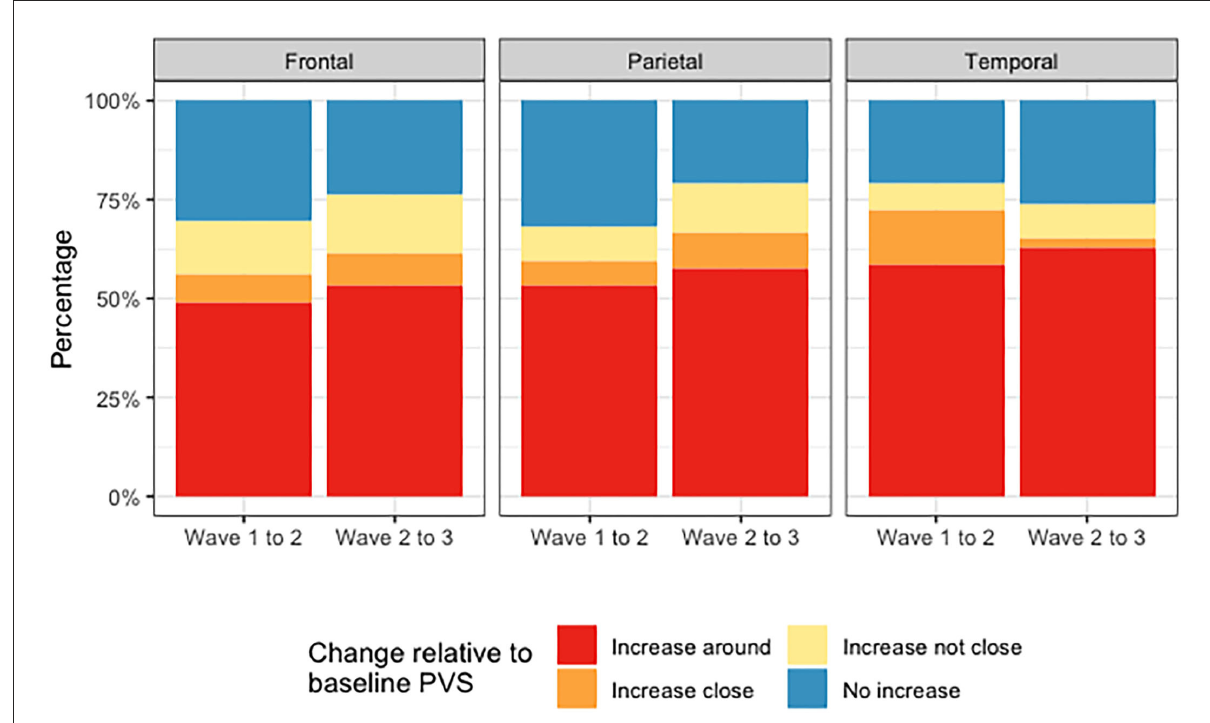
FIGURE10 Percentages of deep WMH that increased around, close and not close to baseline PVS, and did not increase in the frontal, parietal, and temporal regions between waves 1 and 2 and waves 2 and 3.